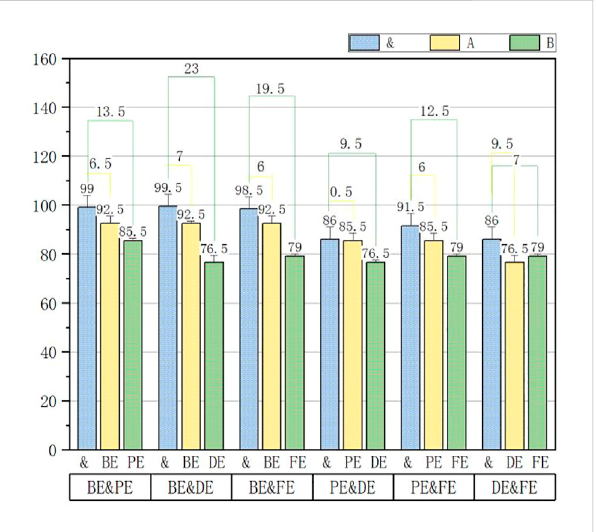
FIGURE 8 Average recognition rate and difference analysis of BSs.